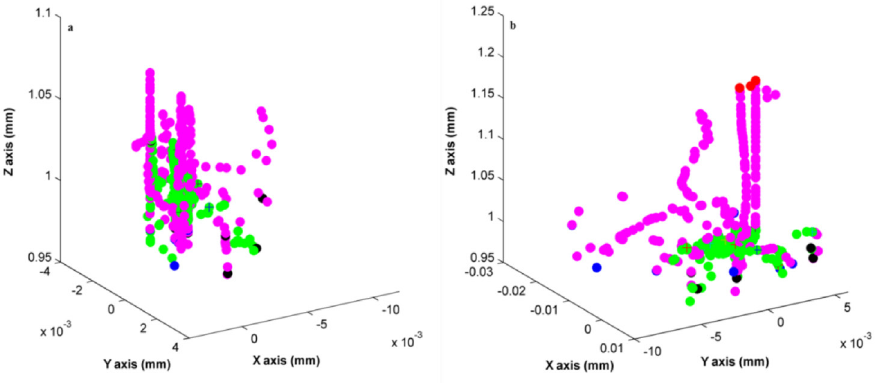
Fig. 4 . X, Y, Z (cm) (a) FNPs=0.08; (b) FNPs=0.98: for better illustration the number of photons are considered 20; Yellow: Start Point; Green: Excitation Scattering; Magenta: Fluorescence Scattering; Blue: Diffuse Reflection; Black: Total Reflection; Red: Transmission; +: Excitation Photon Absorption which is converted to fluorescence emission at different